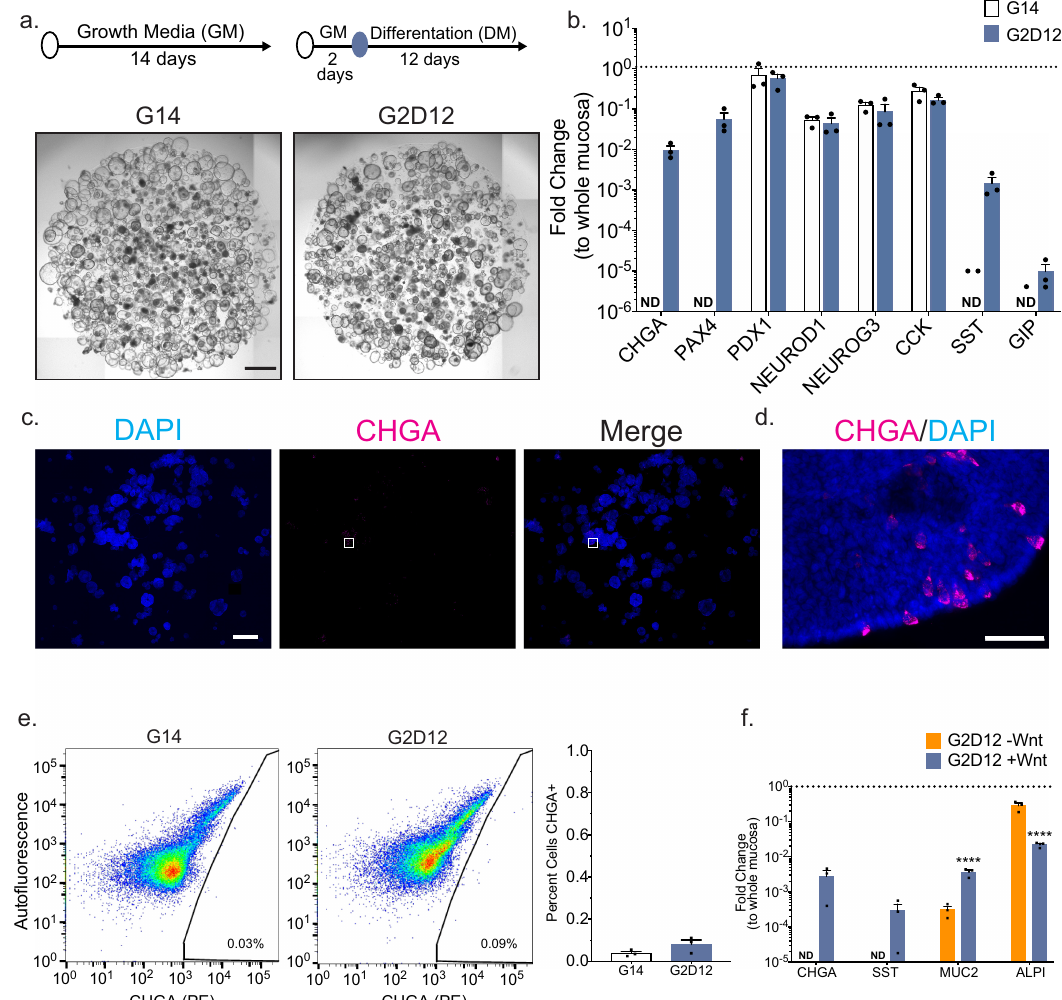
Fig. 1 Base differentiation media induces CHGA expression in a Wnt-dependent manner. a Representative light microscopy of enteroids (whole well) grown in growth media (GM) for 14 days (G14) or two days in GM followed by 12 days in differentiation media (DM, G2D12). Speci fi c culture schematic located above each panel, respectively. Scale bar = 1 mm. b qPCR analysis of enteroendocrine (EE) markers of enteroids grown in either G14 or G2D12 compared to duodenal whole mucosa and normalized to 18S. Dotted line denotes expression level in whole duodenal mucosa. Representative experiment showing n = 3 wells for each condition from a single enteroid line. CHGA = chromogranin A, PAX4 = paired box 4, PDX1 = pancreatic and duodenal homeobox 1, NEUROD1 = neuronal differentiation 1, NEUROG3 = neurogenin 3, CCK = cholecystokinin, SST = somatostatin, GIP = glucose-dependent insulinotropic peptide, ND = not detectable in one or more samples. ( c and d ) Representative immuno fl uorescence staining of CHGA (magenta) in enteroids (whole well) treated with G2D12. Boxed portion in c shown magni fi ed in d . DNA (4 ′ ,6-diamidino-2-phenylindole (DAPI) blue). Scale bars = 1 mm ( c ) and 50 µ m ( d ). e Left two panels: Representative fl ow cytometry plots of CHGA-positive (CHGA + ) cells from enteroids grown in either G14 or G2D12. Right panel: Percentage of CHGA + cells per well. Representative experiment showing n = 3 wells from each condition from single enteroid line. f qPCR analysis of mature intestinal gene markers of enteroids grown in either G2D12 without Wnt (G2D12-Wnt) or with Wnt (G2D12 + Wnt) compared to whole mucosa and normalized to 18S. Dotted line denotes expression level in whole duodenal mucosa. MUC2 = Mucin 2, ALPI = Intestinal alkaline phosphatase. Representative experiment showing n = 3 wells from each condition from a single enteroid line. **** p < 0.0001. Bars show mean ± SEM; two-way ANOVA with Tukey correction for multiple comparisons ( b , f ); two-tailed unpaired t test ( e ). Each experiment repeated with at least three different enteroid lines. Speci fi c conditions were excluded from statistical analysis if the data from one or more samples was labeled as not detectable. Source data are provided as a Source Data fi